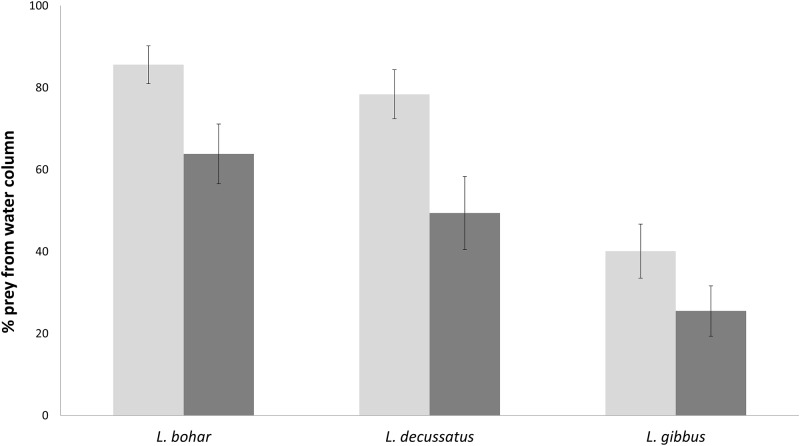
Prey items in guts of three mesopredatory teleost species by origin.Plot of the mean percentage of prey items from the water column (±SE) in the guts at the Scott Reefs (pale grey) and the Rowley Shoals (dark grey) for three species of mesopredator (2x2 Chi-Square contingency table with no fixed margin: L. bohar, χ2 = 30.9, p<0.001, L. decussatus, χ2 = 11.9, p<0.001 and L. gibbus, χ2 = 10.7, 0.001<p<0.005).